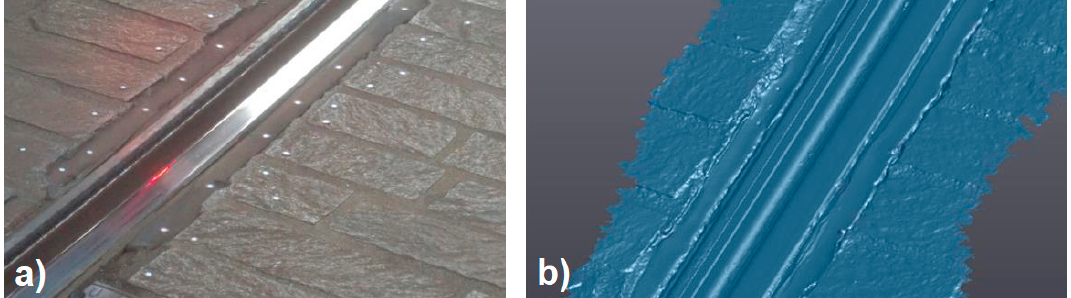
Figure 14. Experimental setup ( a ) and resulting 3D digital model ( b ).